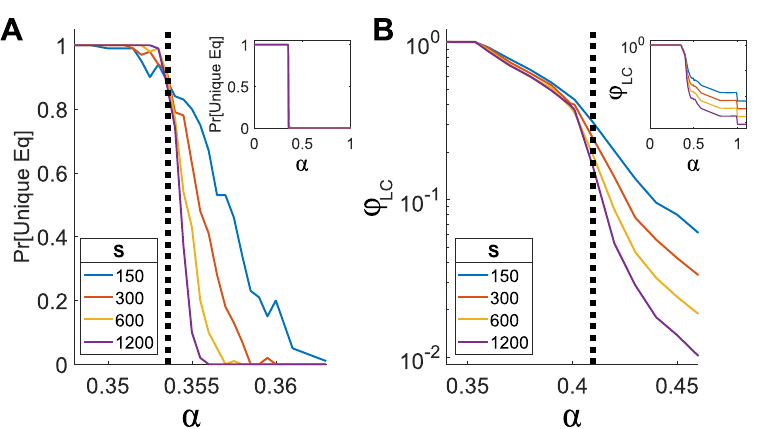
Fig 3. Collective transitions. (A) Unique to multiple equilibria transition: the probability for a unique equilibrium as a function of α , for connectivity C = 3 and several pool sizes S . The probability is obtained by generating many realizations of interaction matrices and determining whether there is a unique equilibrium by the stability of the fully- feasible fixed point, as described in the text body. The exact value for the transition, calculated using Eq (3), is shown as a dashed black line. Inset: the same graph over a larger range of α . The transition becomes sharper with S grows, as expected from a collective transition. (B) Percolation transition: the fraction of species in the largest connected component as a function of α , for several values of S . The location of the transition is α perc � 0.41 ± 0.01 (dashed black line). At α < α perc a finite fraction of species belongs to the largest component even when S grows. At α > α perc , this fraction decreases with S . Inset: the same graph over a larger range of α . Here too, the transition becomes sharper at larger values of S